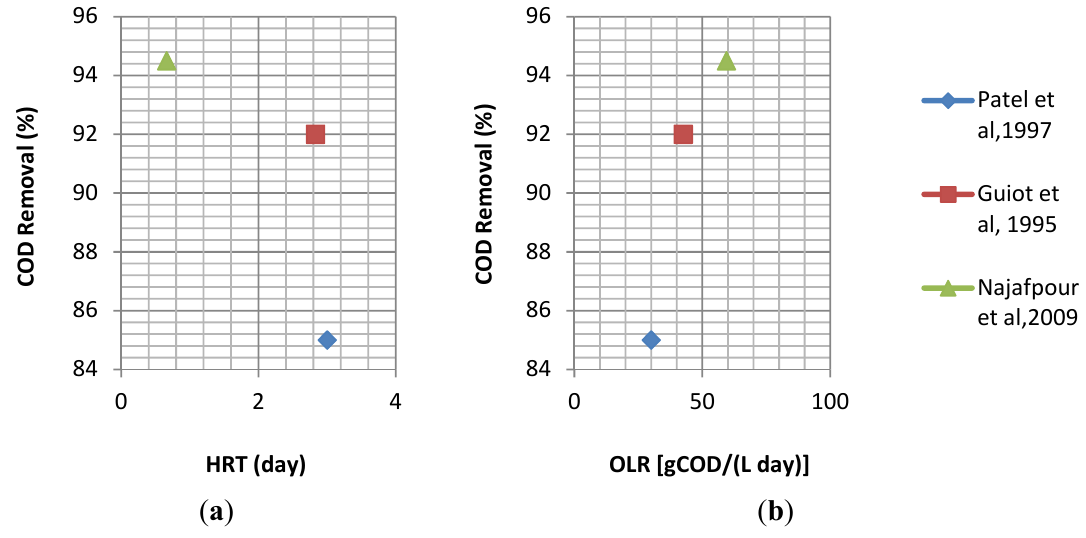
Figure 6. Maximum COD removal versus ( a ) HRT (days) and ( b ) OLR [g COD/(L day)] using alternative types of reactors for CW